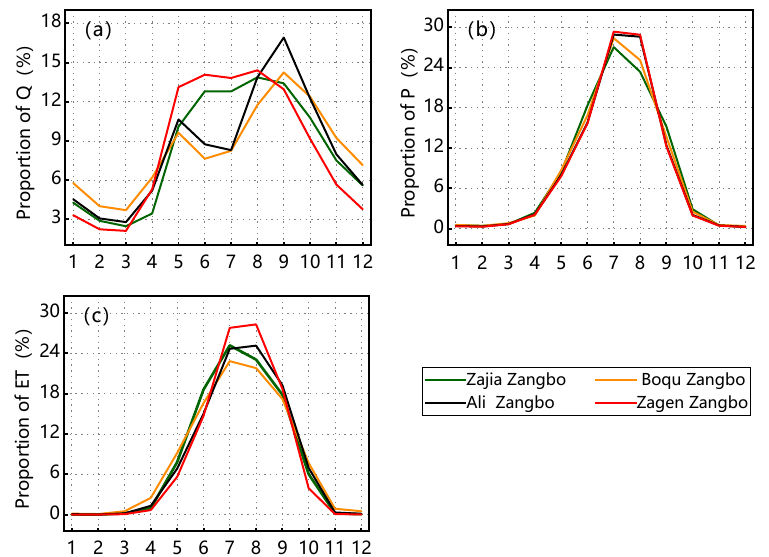
Figure 12. Distribution of multiyear monthly average ( a ) discharge, ( b ) precipitation and ( c ) evapora- tion in the sub-basins.